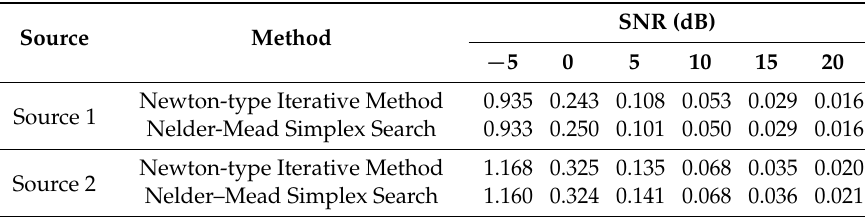
Figure 9. The estimated RMSEs versus SNR for far-field sources. ( a ) Source 1; ( b ) Source 2. Table 5. The estimated RMSEs of the proposed DPDs using the Newton-type iterative method and Nelder–Mead simplex search for far-field sources (km).